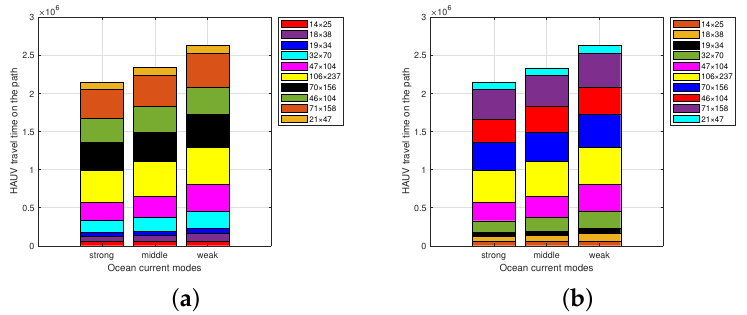
Figure 12. HAUV travel time on the paths established by two algorithms in the ten grid maps. ( a ) HAUV travel time on the paths established by the improved A* algorithm in the ten grid maps. ( b ) HAUV travel time on the paths established by neural network model in the ten grid